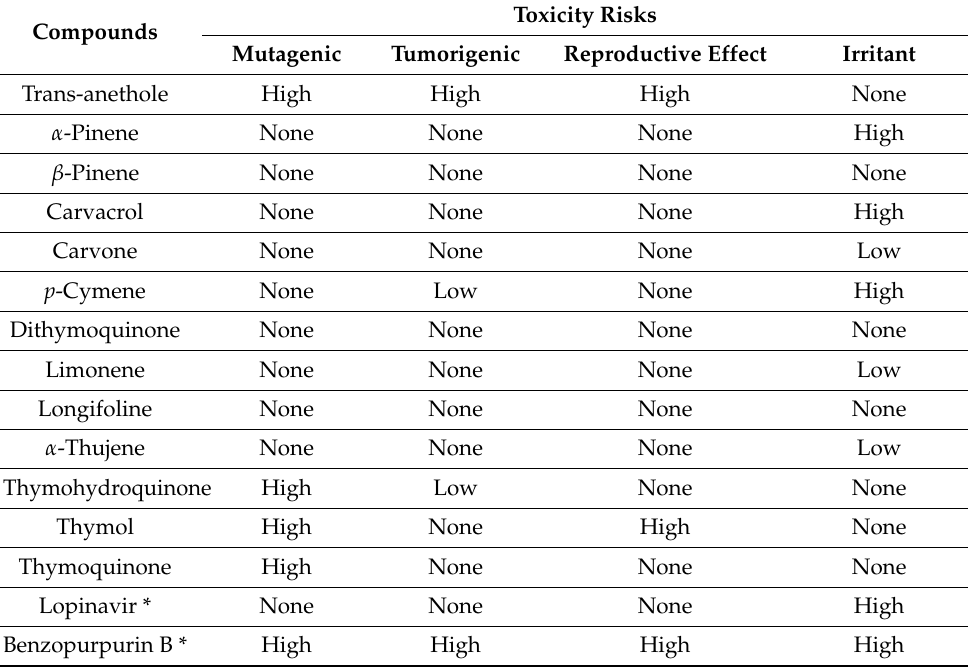
Table 3. Toxicity potential of ‘active components of Nigella sativa ’ and ‘control compounds’.